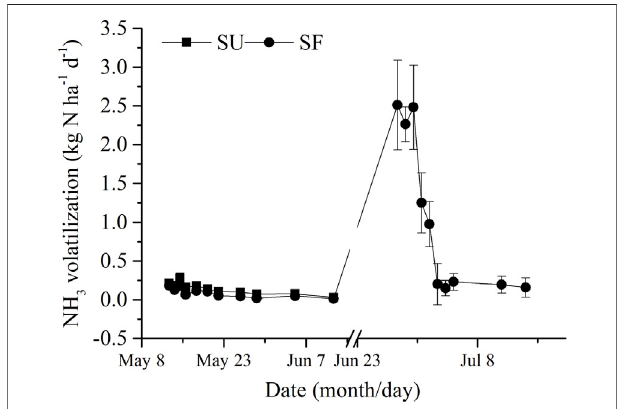
FIGURE 7 | Dynamics of ammonia volatilization under different treatments. The bars represent the standard deviations of the means ( n (cid:2) 3).